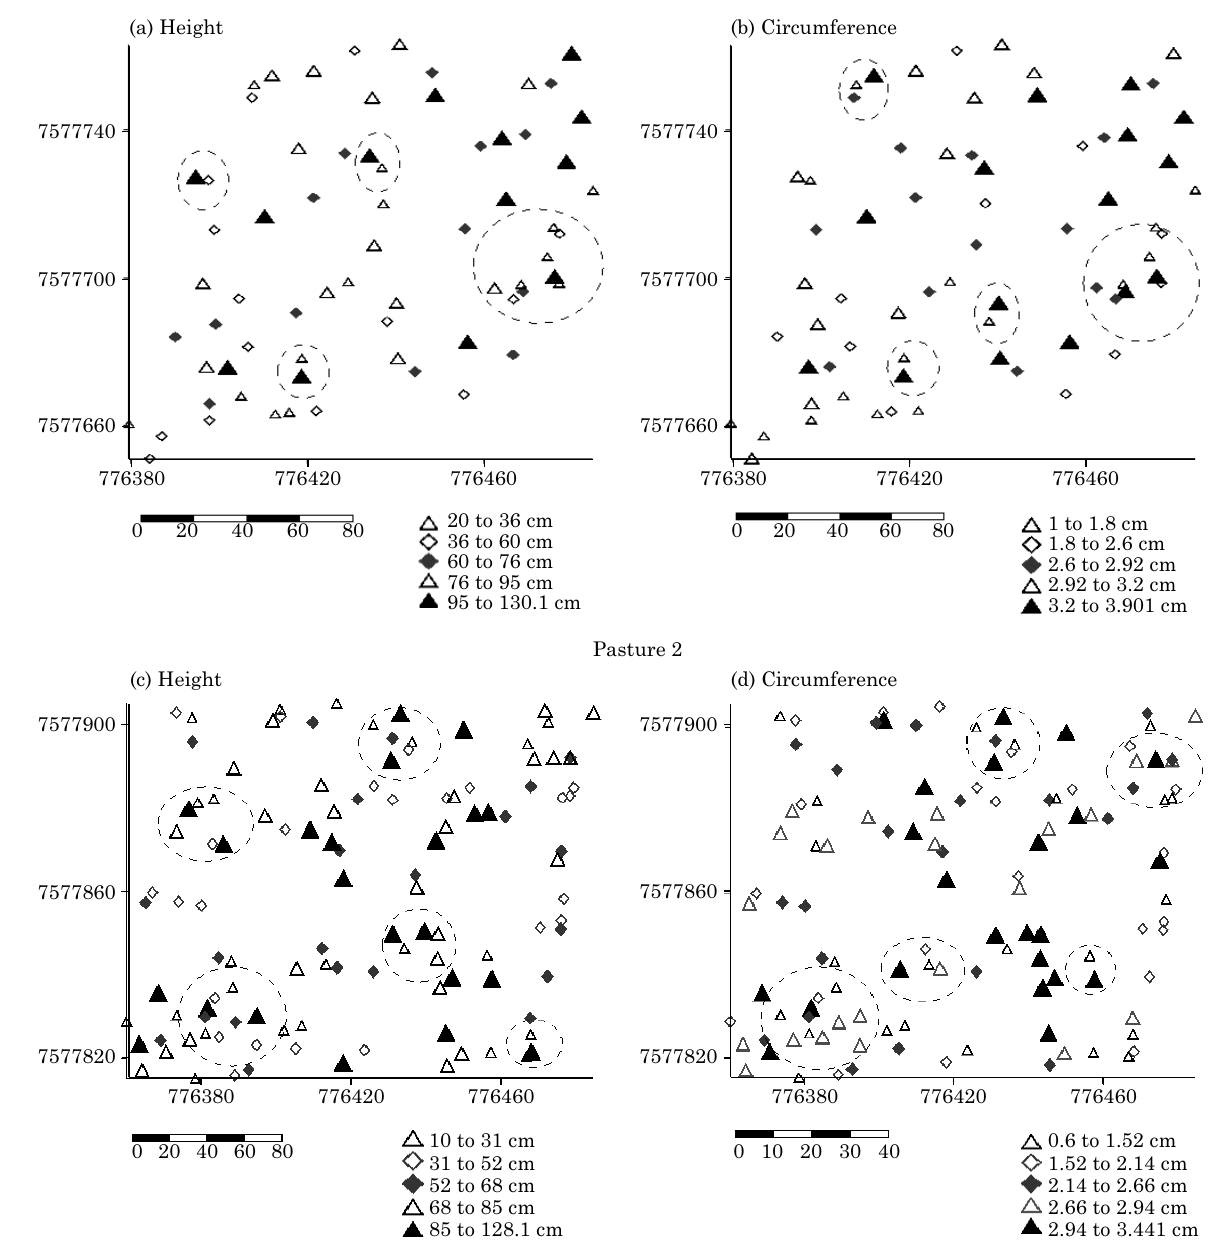
Figure 4. Spatial distribution of height (a, c) and circumference (b, d) measurements of epigeous termite mounds in Pasture 1 and 2, respectively, on the Fazenda Campana, Rio Brilhante, MS. The circles in the graph explain the random distribution of